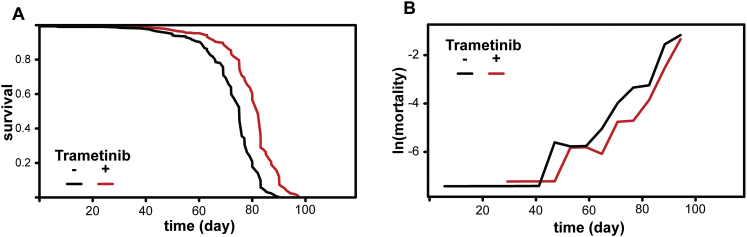
Mortality Analysis of Flies Exposed to 15.6 μM Trametinib, Related to Figure 5(A) Combined survival data from three independent trials of wDah females exposed to 15.6 μM trametinib. Log-rank detected a significant difference in survival between trametinib-treated flies and untreated controls (increase in median lifespan of 9%, p < 0.0001). Controls: n = 338 deaths/8 censors, median lifespan = 75 days; trametinib-treated: n = 325/28, median lifespan = 82 days.(B) Age-specific mortality analysis of the survival data in (A). Mortality (μx) was calculated as: μx = -ln(1-qx), where qx (the probability of dying in a time interval) was averaged per day over a 5-day interval and is shown at the end of the interval. Intervals with zero deaths were removed. Estimates of the parameters of the Gompertz mortality model: λ (baseline mortality) controls = 7.3x10−6, trametinib-treated = 2.3x10−6, p = 0.045; γ (change in mortality with age) controls = 0.13, trametinib-treated = 0.13, p = 0.67.